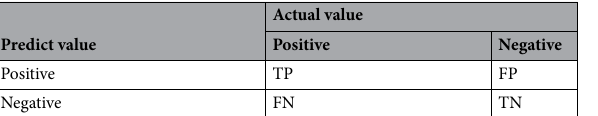
Table 1. Model evaluation index. Note: (True Positive (TP), False Positive (FP), False Negative (FN), True Negative (TN)).